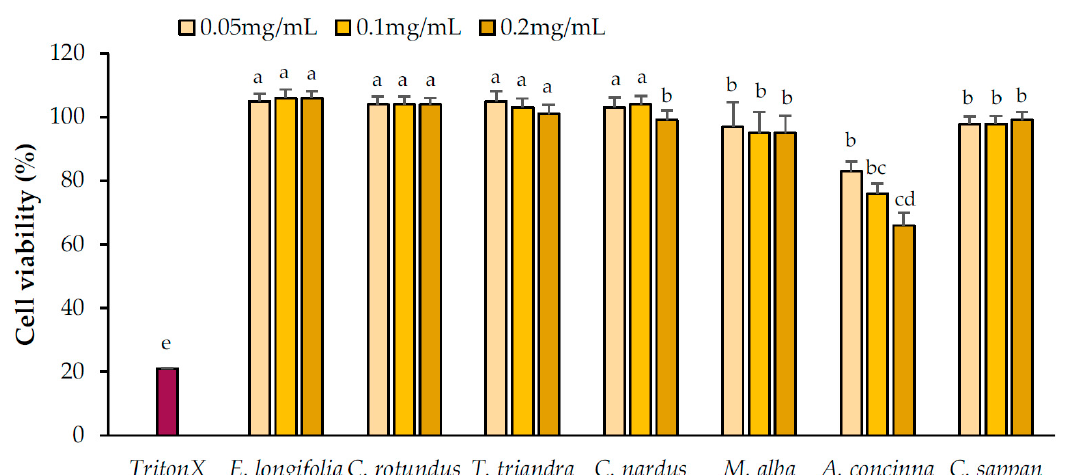
Figure 5. Cell viability after treatment with the candidate plant extracts. Triton X-100 (positive control) was used at 0.1% v/v. Data are expressed as means ± standard deviation. Means with different letters are significantly different (Tukey’s test, p < 0.05).